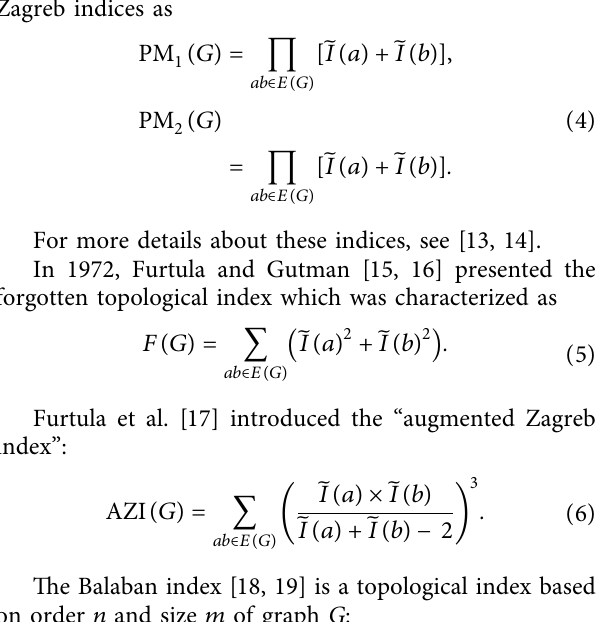
Figure 2: Unit cell structure of terbium oxide